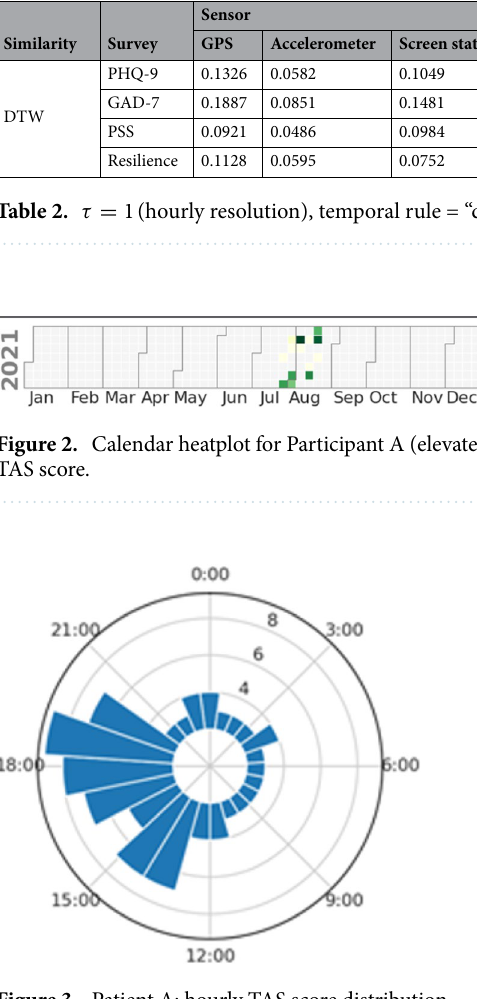
Figure 3. Patient A: hourly TAS score